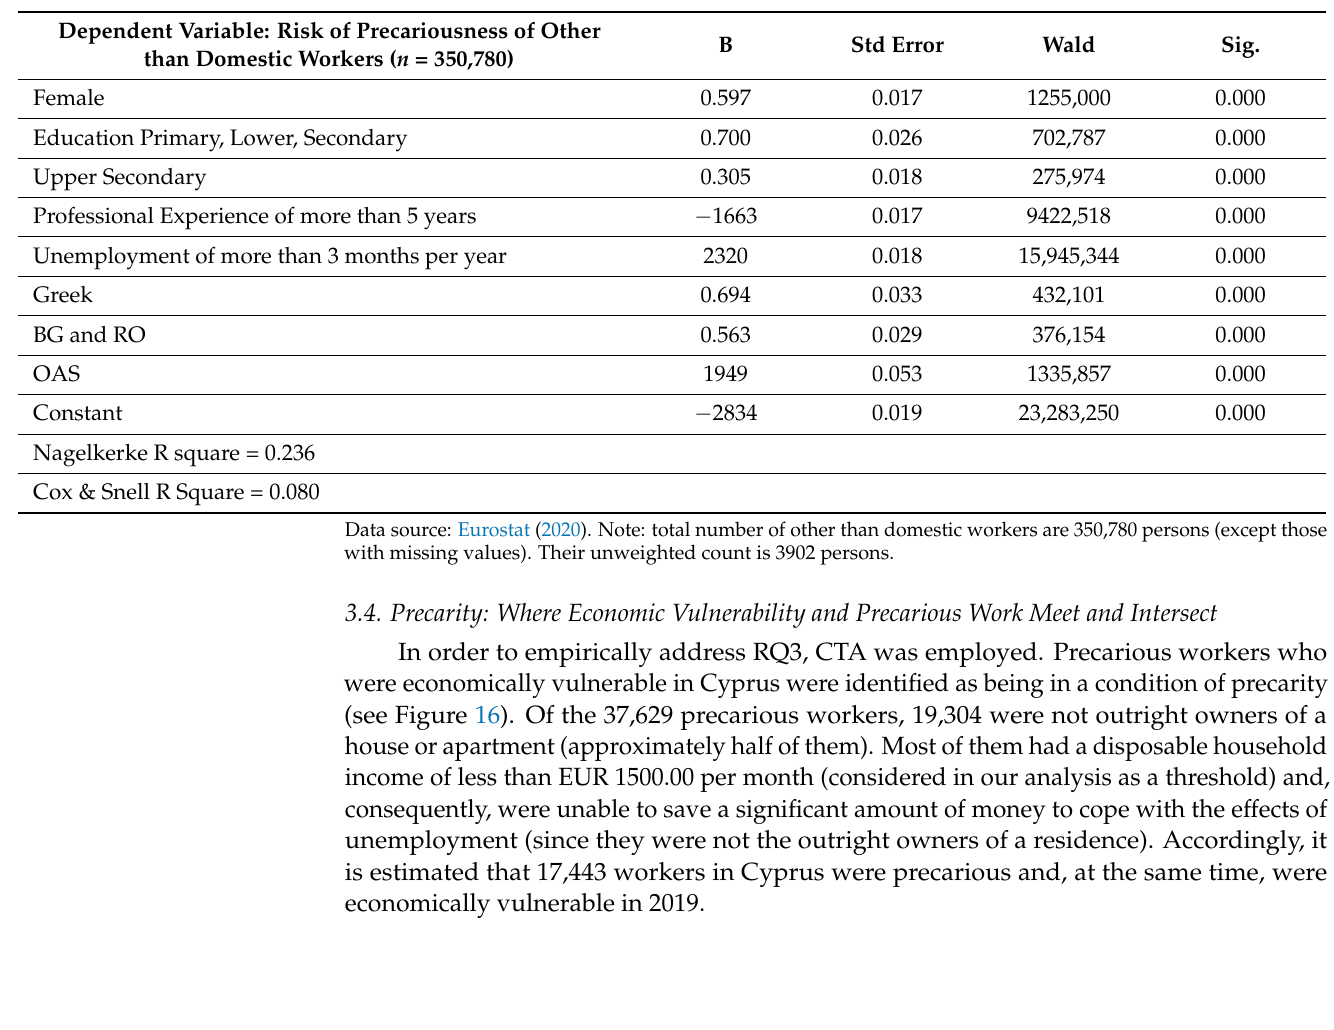
Table 6. The results of the stepwise logistic regression: personal characteristics affecting the risk of precariousness of Other than Domestic